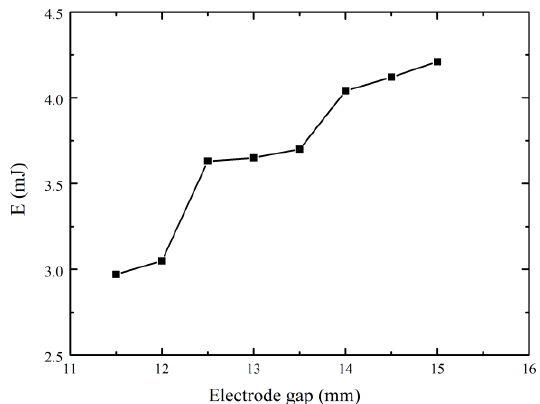
Figure 3. The light energy for different electrode distance relationships.